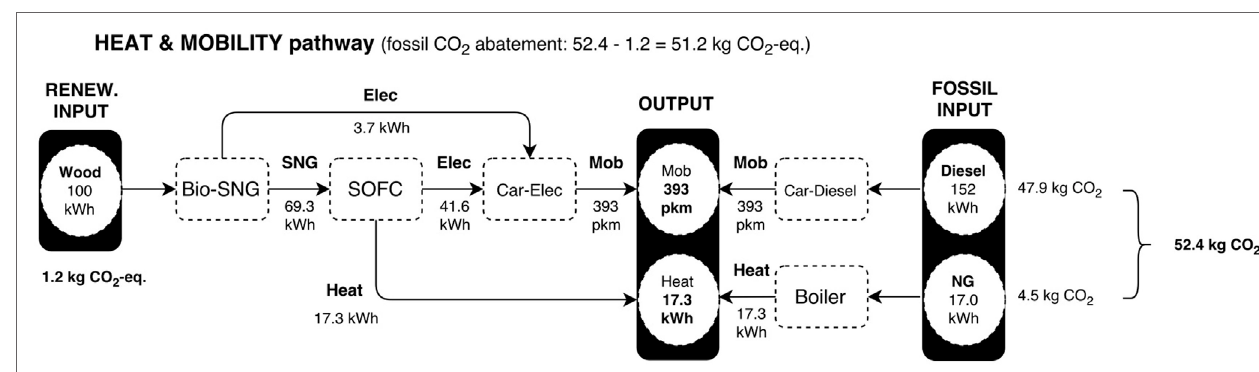
FigUre 6 | Substitution pathway example for the heat and mobility approach.